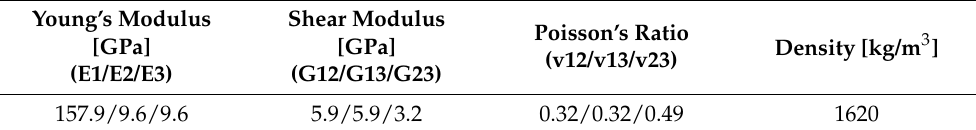
Table 1. Mechanical properties of the CFRP